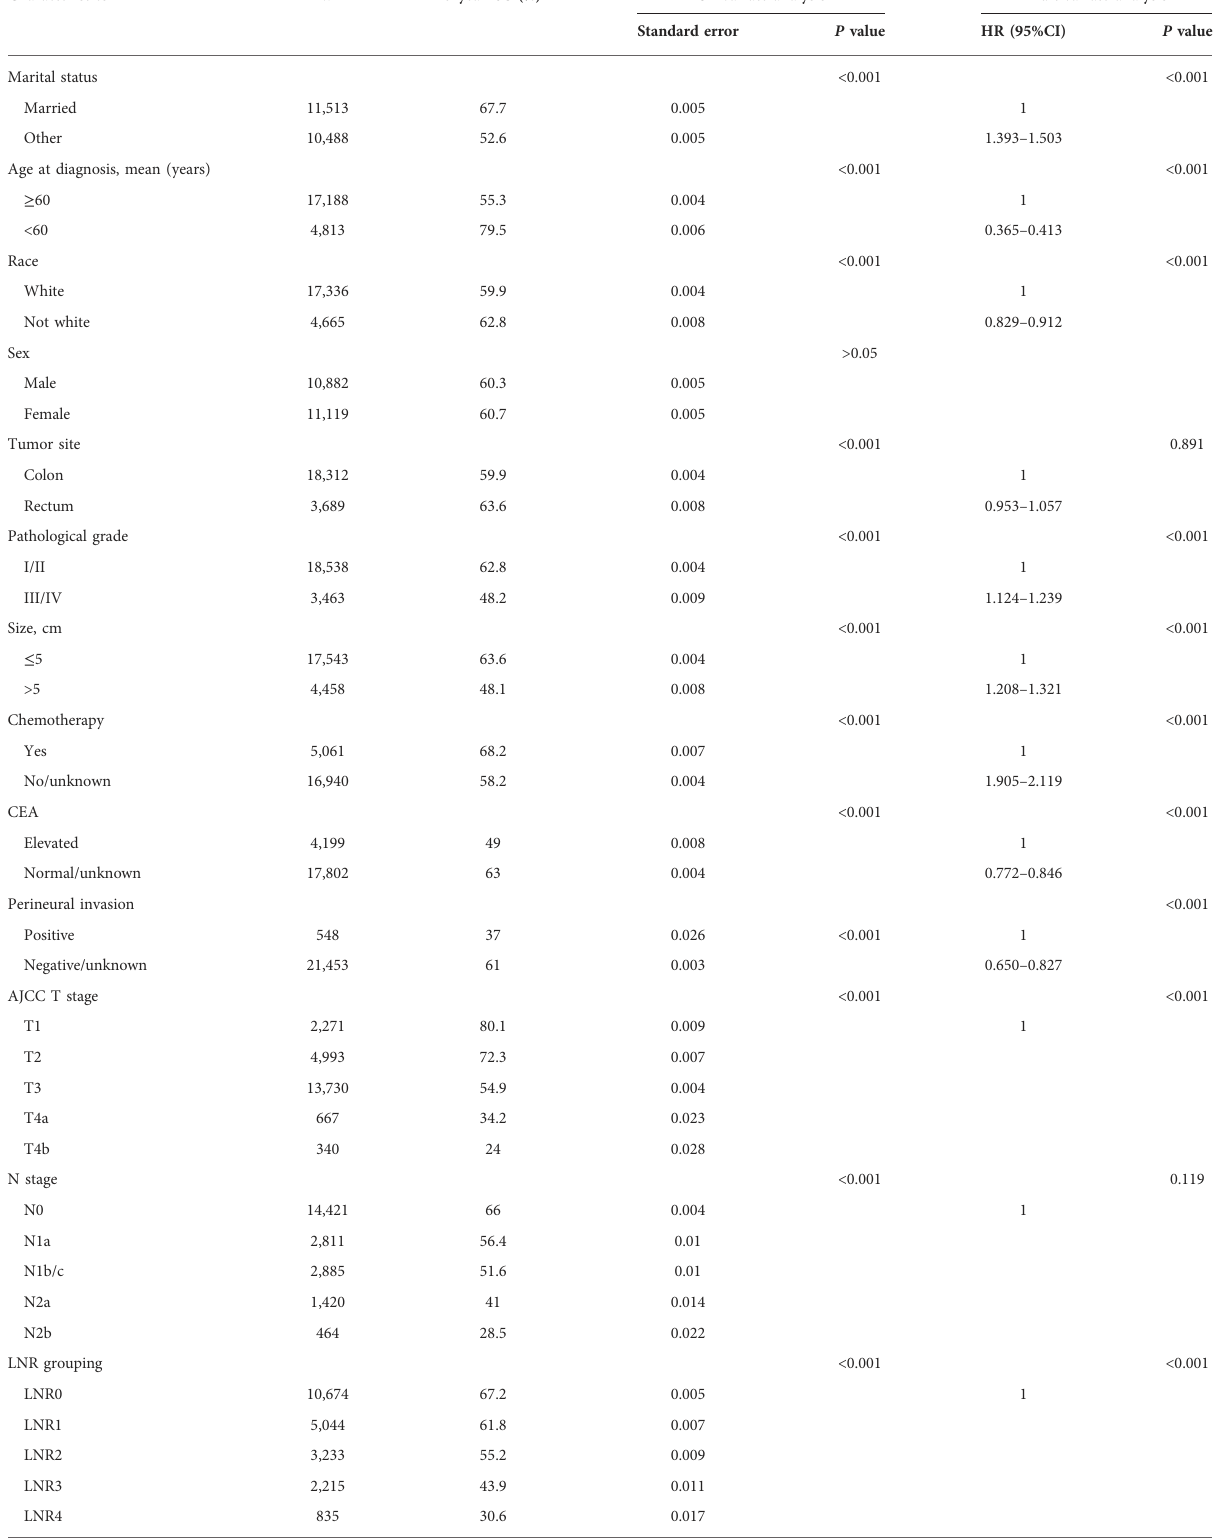
TABLE 3 Univariate and multivariate analyses identifying factors associated with the prognosis of patients with